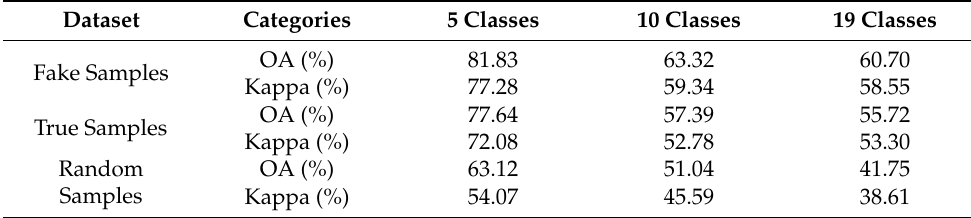
Table 5. Classification results under different numbers of